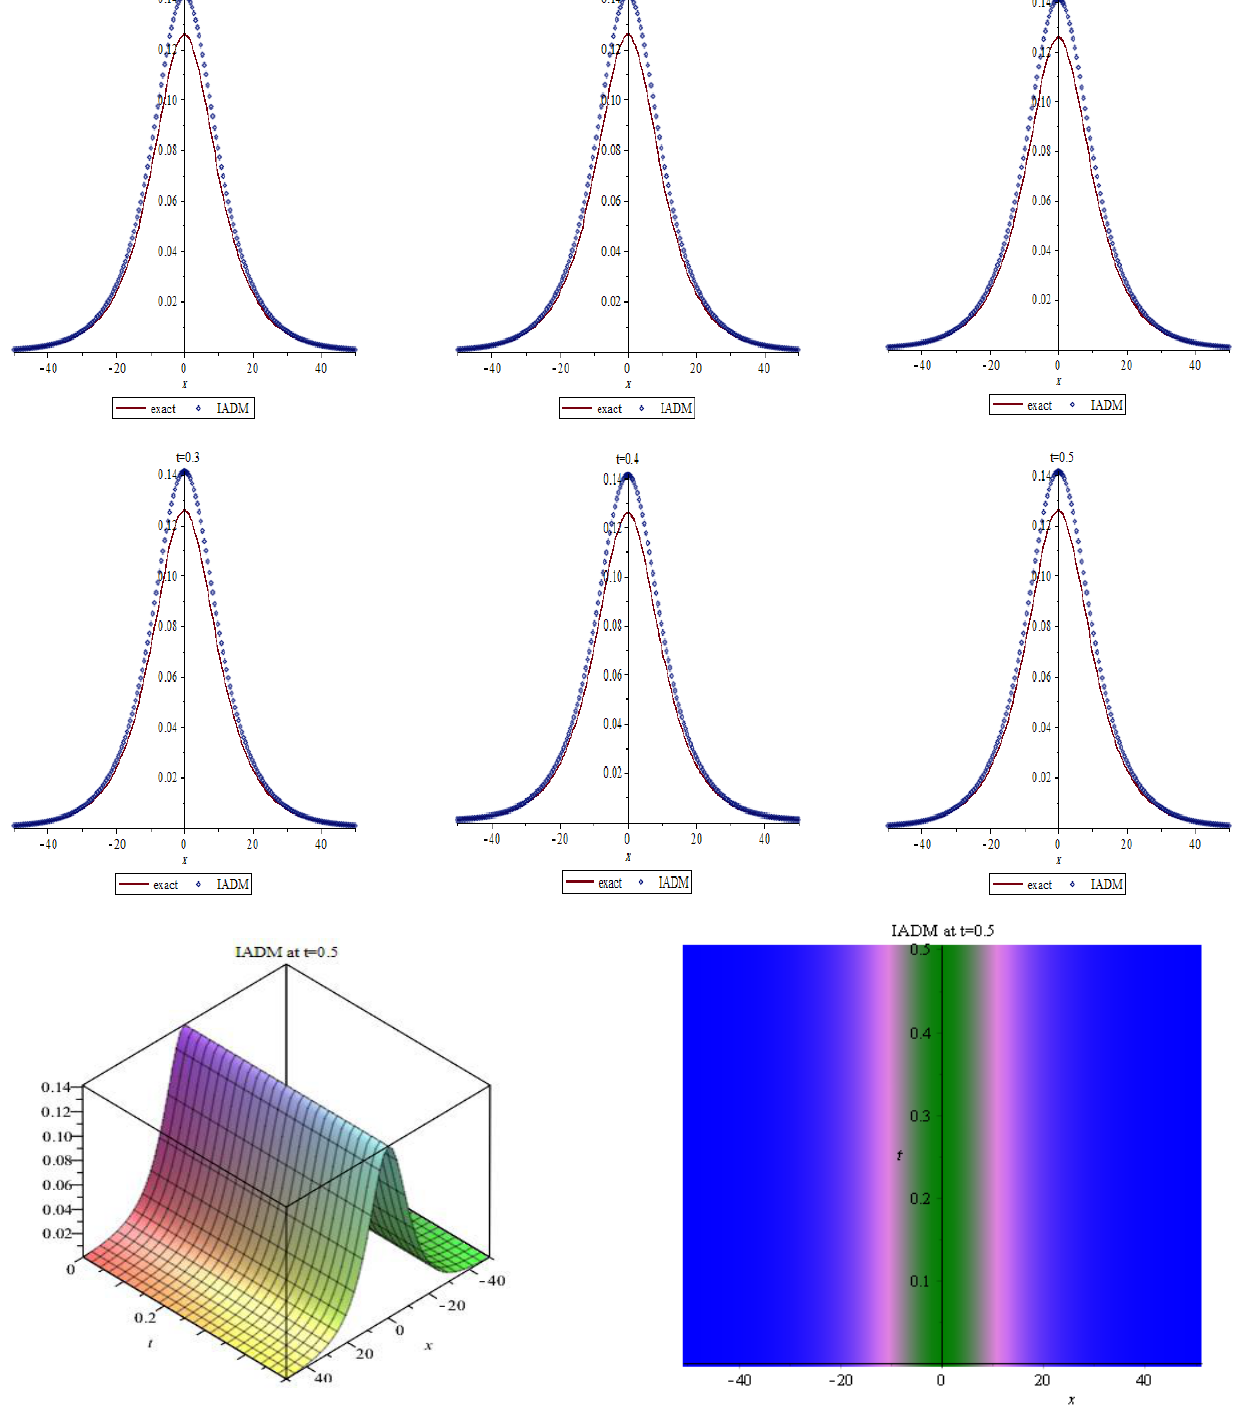
Figure 1. Comparison of the exact and improved ADM solutions for case 1 for −50 ≤ x ≤ 50 .